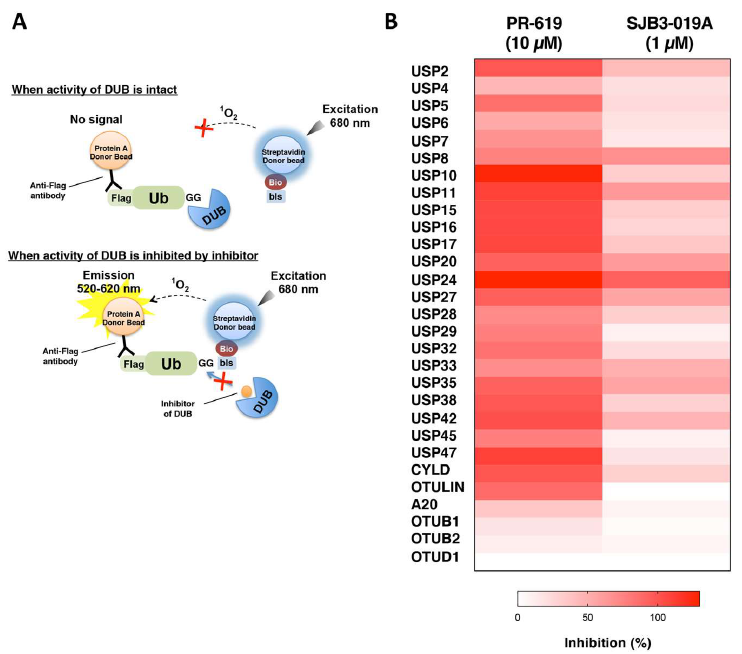
Figure 4. AlphaScreen-based evaluation of DUB inhibitors. ( A ) Schematic diagram of the assay. ( B ) The results of the evaluation of two DUB inhibitors, PR-619 and SJB3-019A. PR619 was used as a non-specific DUB inhibitor, and SJB3-019A was employed as relatively specific to some DUBs. The data are indicated as